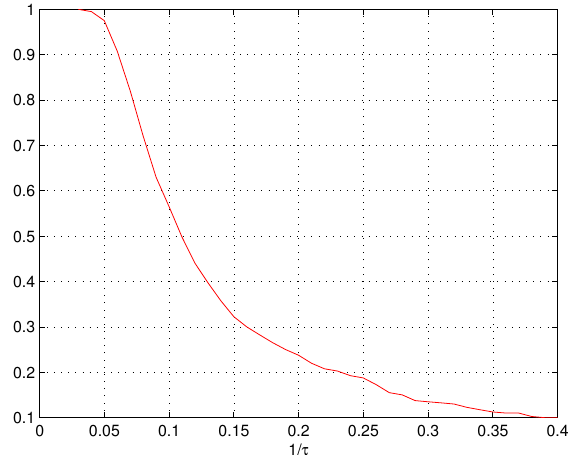
Figure 1. probability of correct recovery with different values of τ